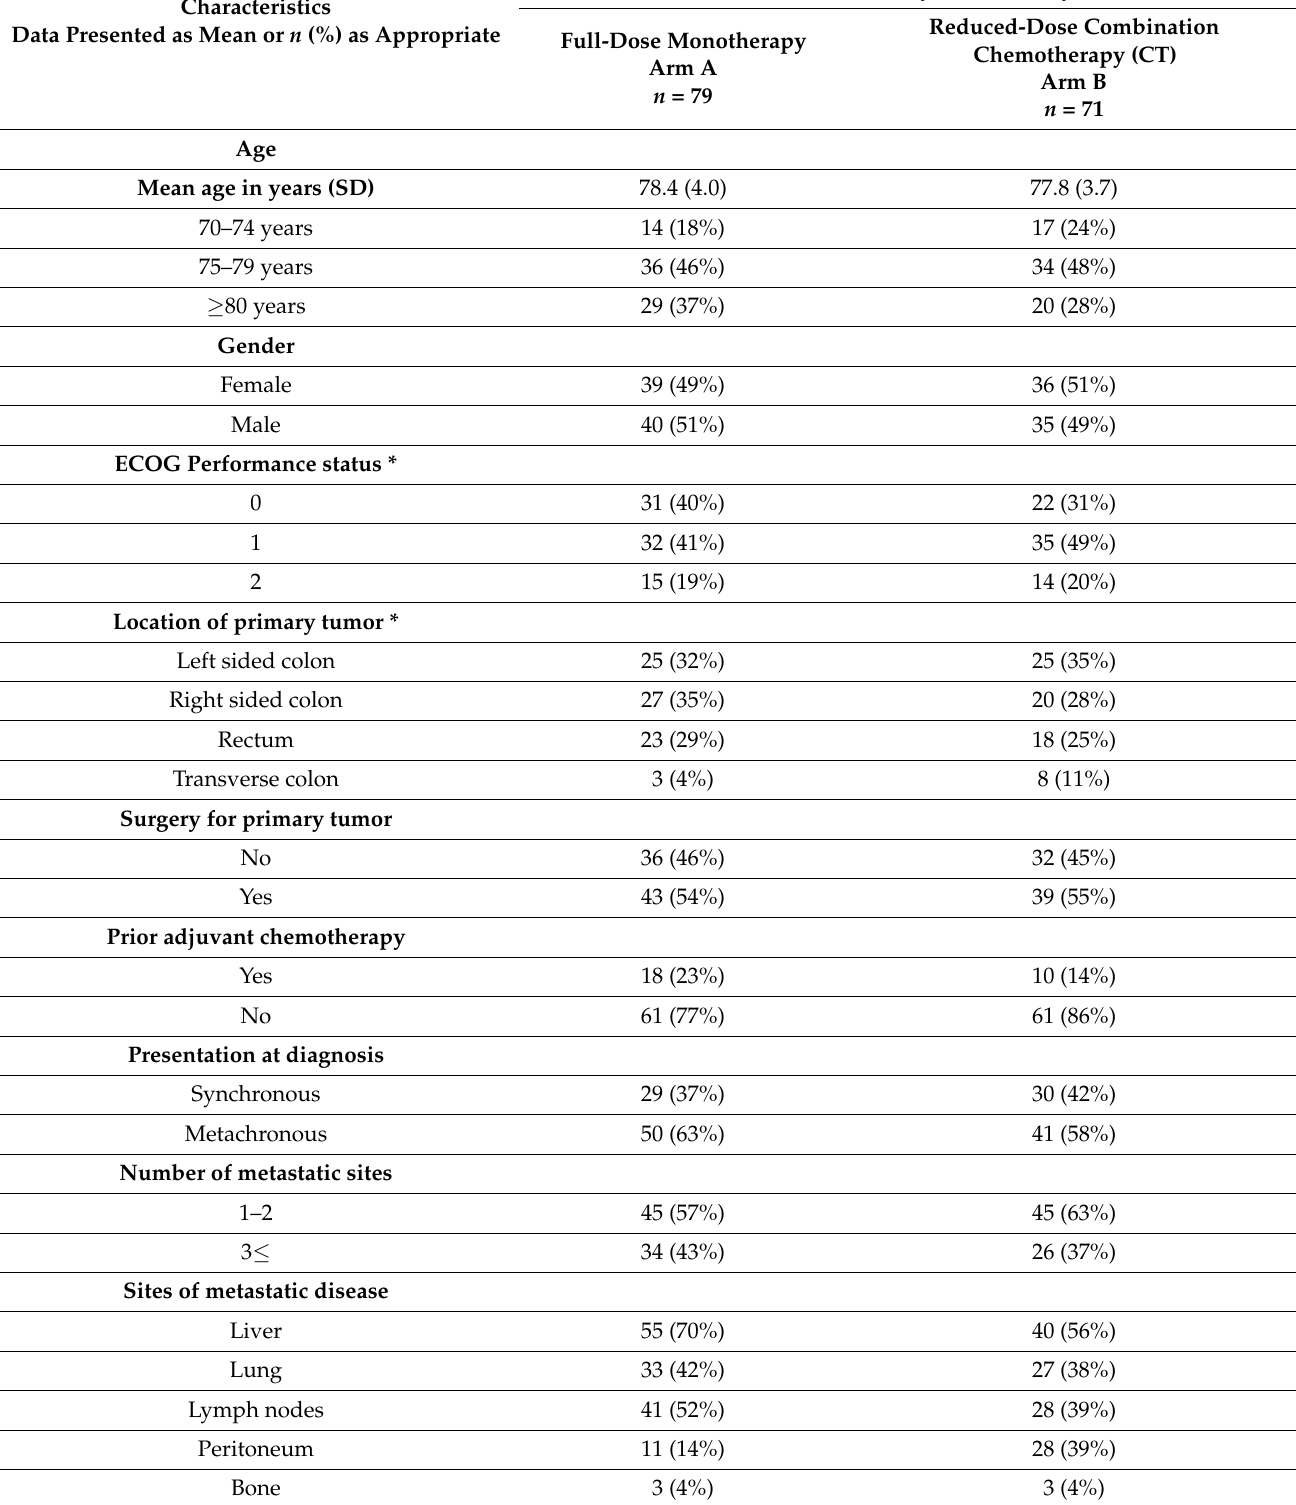
Table 1. Baseline demographic and clinical characteristics of patients included in the quality of life analyses of the randomized